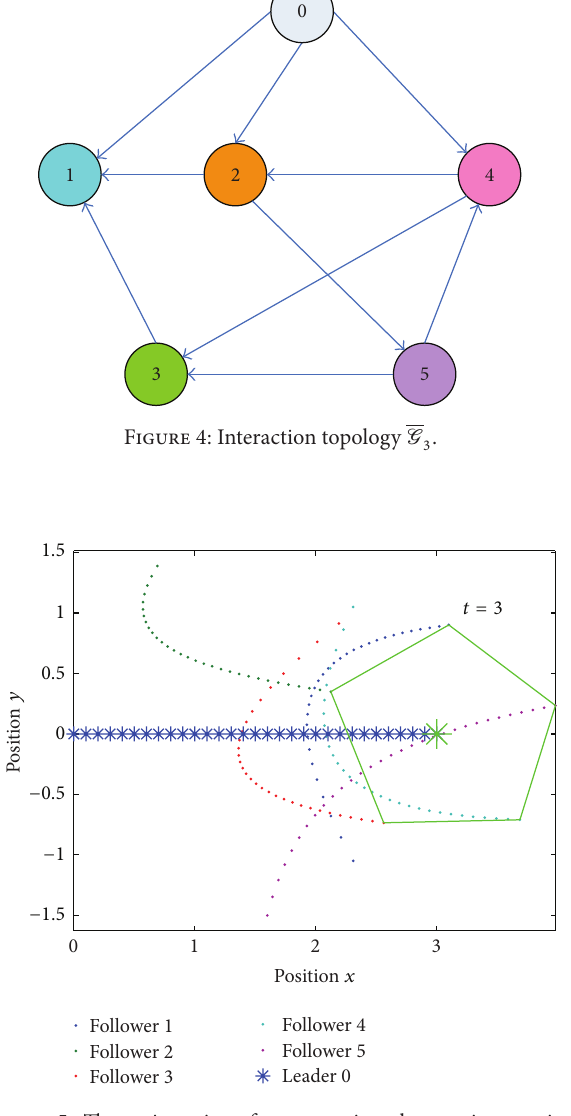
Figure 5: The trajectories of agents using the continuous-time protocol